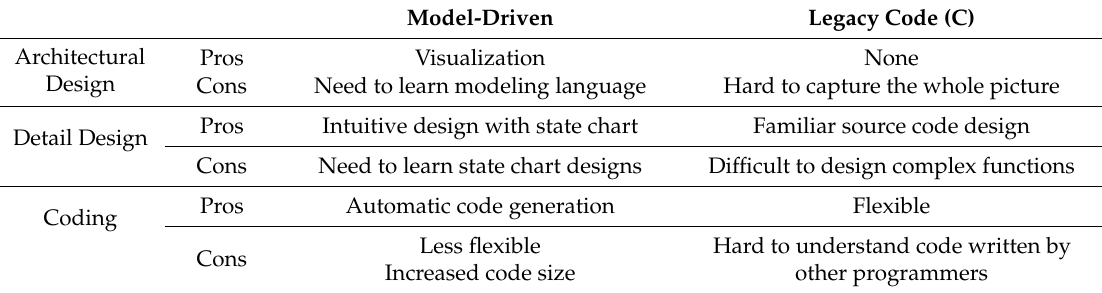
Table 3. Model-driven versus legacy